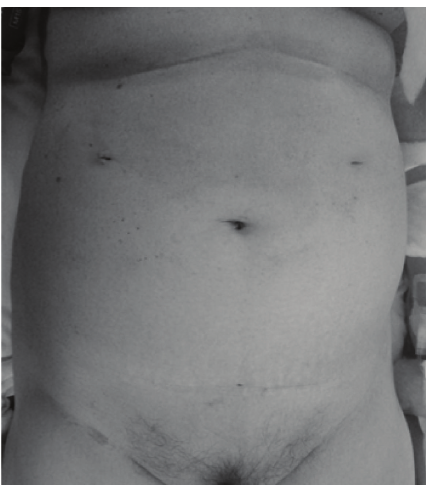
Figure 3: Photograph showing the postoperative scars for the three 5 mm ports that were inserted into the abdomen.